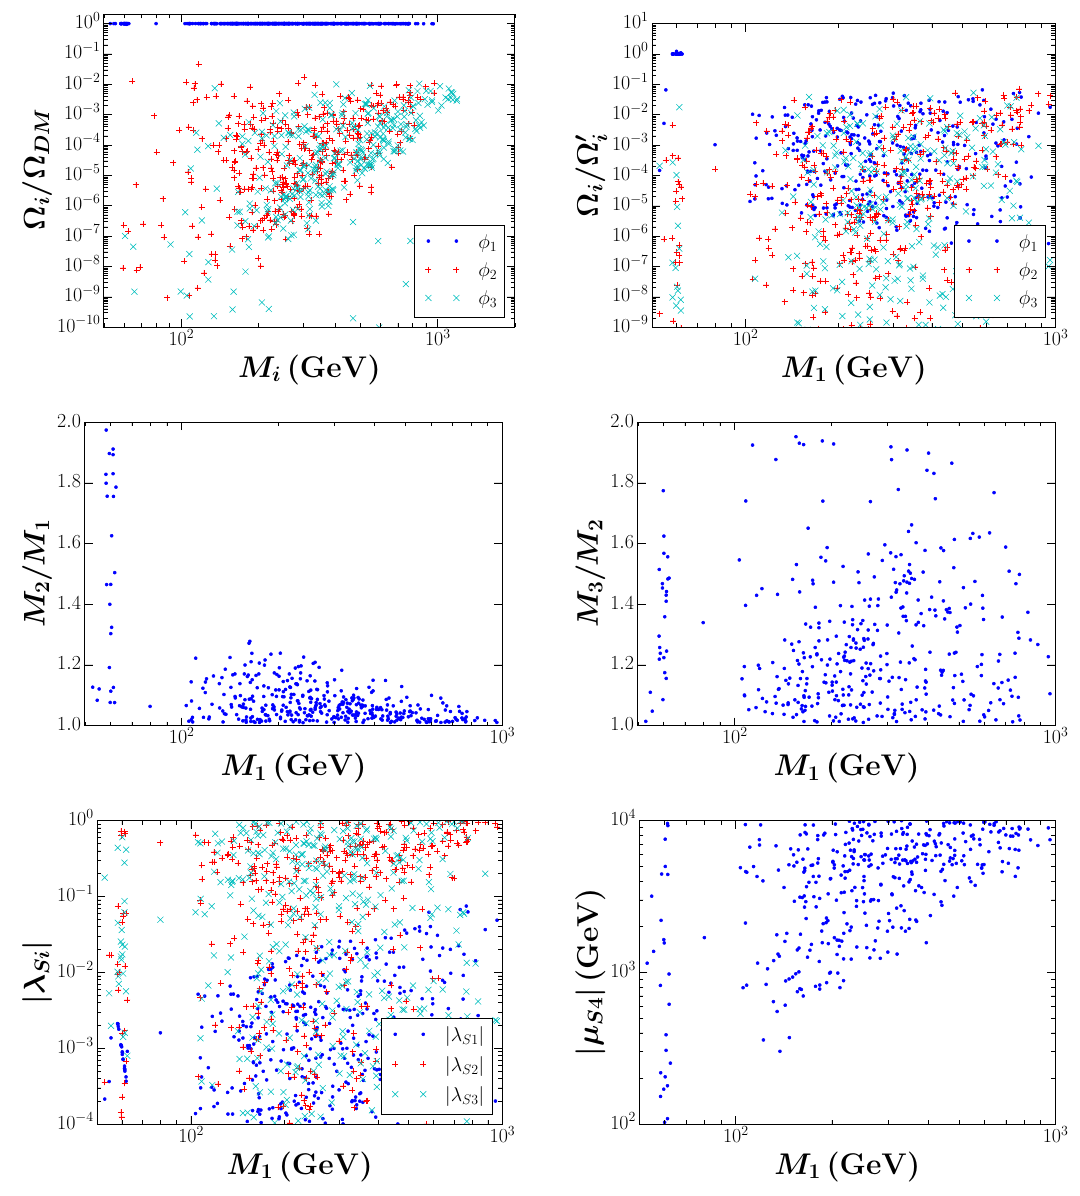
Figure 3 . The viable regions for µ S 4 6 = 0 (scan A). All points shown in these plots are compatible with current